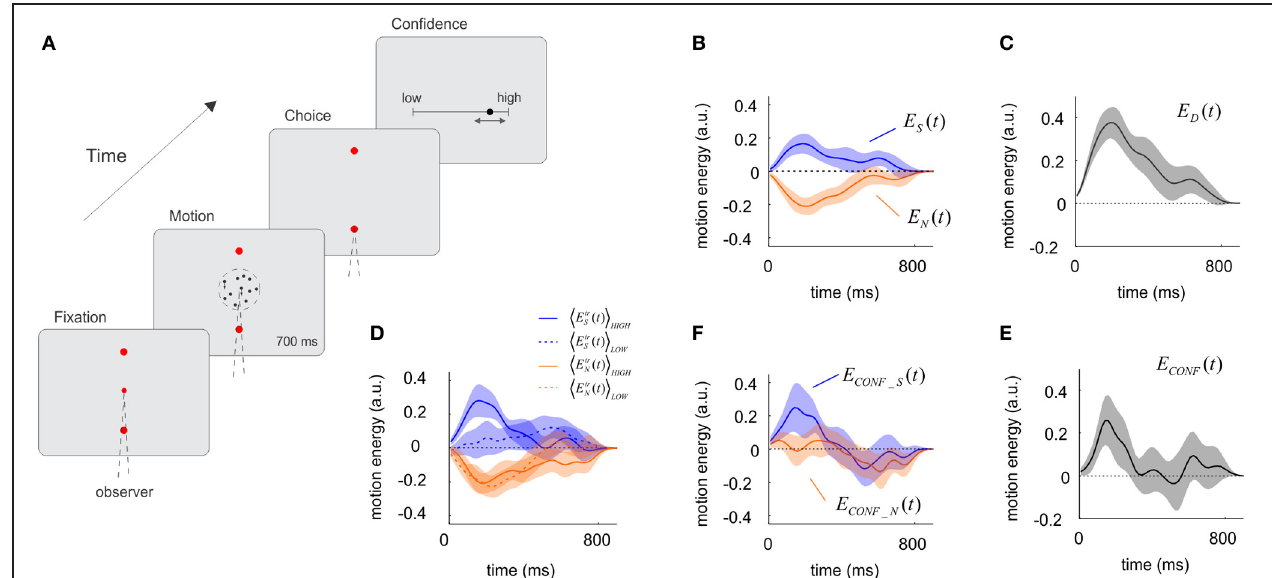
FIGURE 1 | The influence of sensory evidence on choice and confidence derived from a motion discrimination task. (A) A trial of the motion task. The motion stimulus was presented for 700ms after which participants signaled the response with an eye-movement and made a confidence report on a continuous scale ranging from complete chance on the left to absolute certainty on the right. Motion coherence was set to maintain accuracy at 67%. On average, confidence reports on correct trials were higher than on incorrect trials (one-tailed paired t -test, p < 5 . 10 − 8 , df = 18). (B) Influence of motion energy fluctuations on choice. Motion energy fluctuations were obtained by applying a filter to the random dot stimulus and subtracting the mean motion energy set by the trial’s motion coherence and direction. Upward and downward fluctuations were derived independently, and then